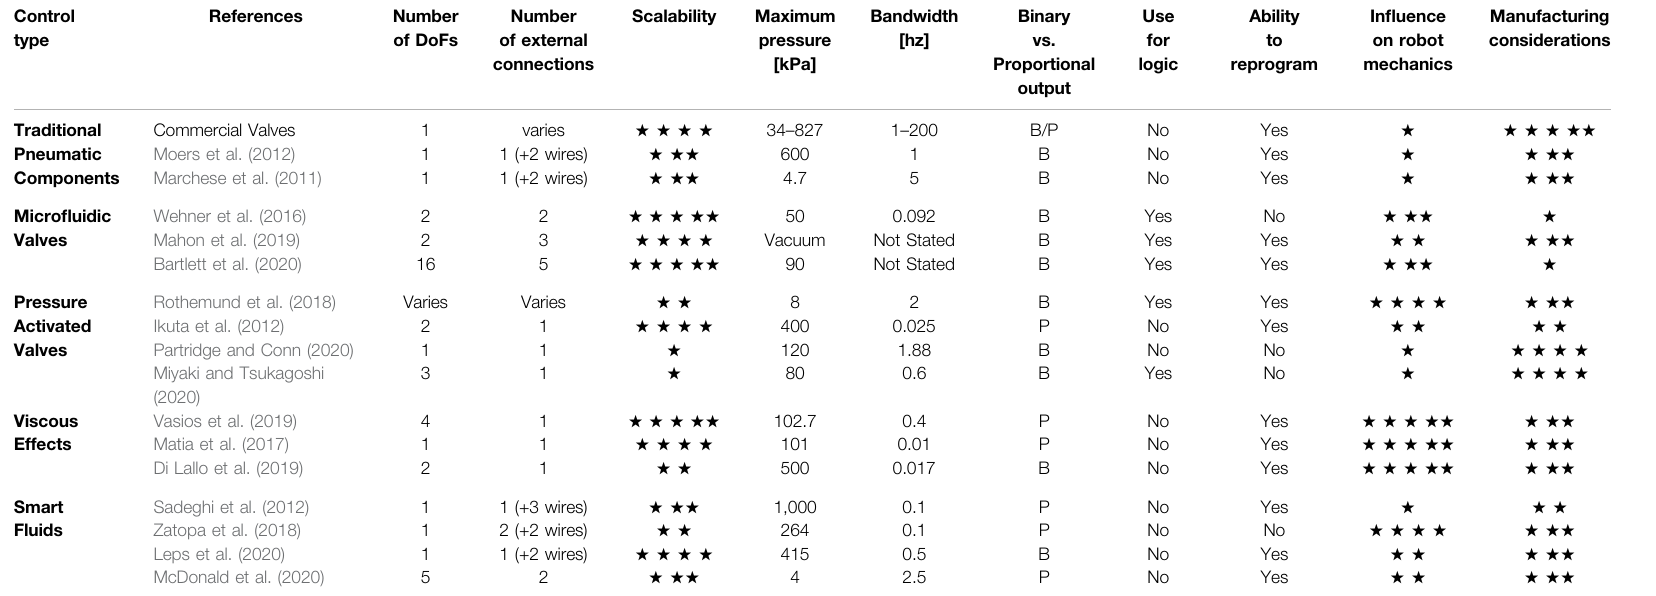
TABLE 2 | Summary of soft robot control methods and the criteria for comparison. For the number of external connections, the number listed is for pressure tubes, except for wires where noted. For scalability 5 stars represents dimensions below 1 mm, four stars is millimeter scale, three stars is up to approximately 1 cm in any dimension, two stars is up to 5 cm in any dimension, and one star is greater than 5 cm in any dimension. Bandwidths are all converted to frequencies in Hz for ease of comparison. In fl uence on robot mechanics is provided on a scale where 5 stars represents a method with little tono in fl uence and one star represents a method which is substantially rigid. Manufacturing considerations are provided as a ranking of complexity for the end user. A 5 star method is an off-the-shelf component which requires no manufacturing, a three star requires only small equipment typically available in a soft robotics lab, and a one star method requires numerous manufacturing steps and specialized equipment such as that for